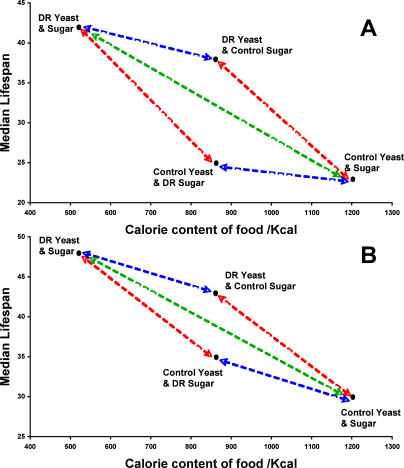
Plot of Median Life Span of Female Drosophila against the Estimated Caloric Content of the Food Medium(A) and (B) represent independent repeats. Red arrows link pairs of food types where differences in caloric content are due to different yeast concentrations. Blue arrows link pairs of food types where differences in caloric content are due to different sugar concentrations. Green arrow links food types where differences in caloric content are due to both different sugar and yeast concentrations. Life span is extended to a greater extent per calorie by reducing yeast concentration from control to DR levels than by reducing sugar. This is in contrast to what would be predicted if calorie intake were the key mediator of life-span extension by DR in fruit flies.